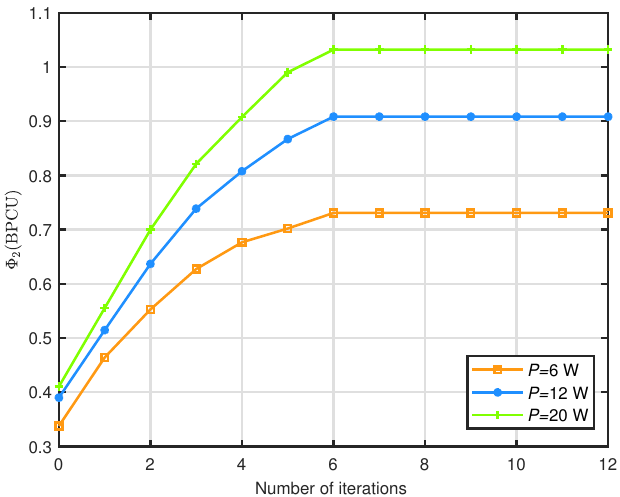
Figure 2. Convergence behavior of Algorithm 1 for various values of P .